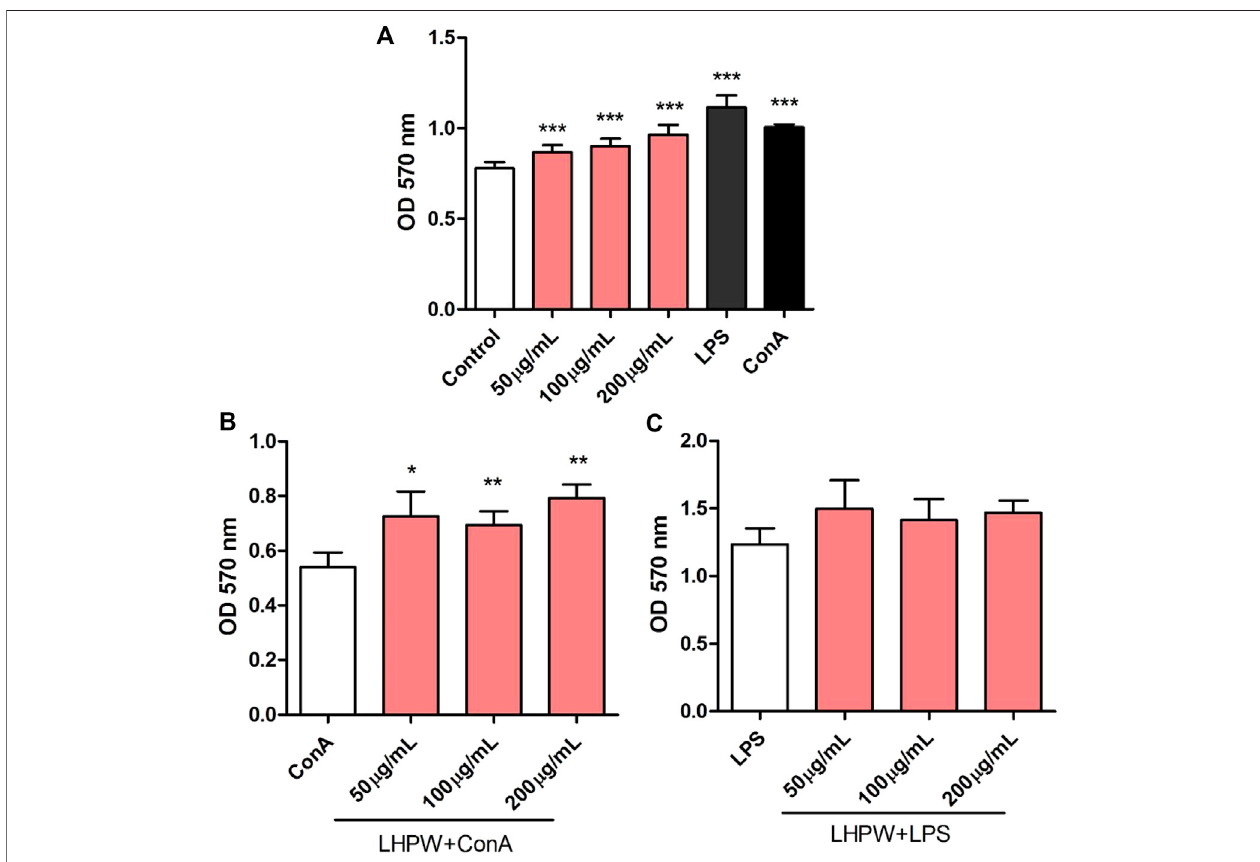
FIGURE 6 | Effects of LHPW on splenocyte proliferation. The mice spleen cells were incubated with LHPW at different concentrations (50, 100, and 200 μ g/ml) alone (A) , in the presence of mitogens Con A (5 μ g/ml) (B) or LPS (2 μ g/ml) (C) for 48 h. MTT was added and incubated. The optical density was then measured at 570 nm. Data were shown as mean ± SD of three independent experiments. ( ppp ) p < 0.001, ( pp ) p < 0.01, and ( p ) p < 0.05 compared with the control group (A) , ConA group (B), or LPS group (C)